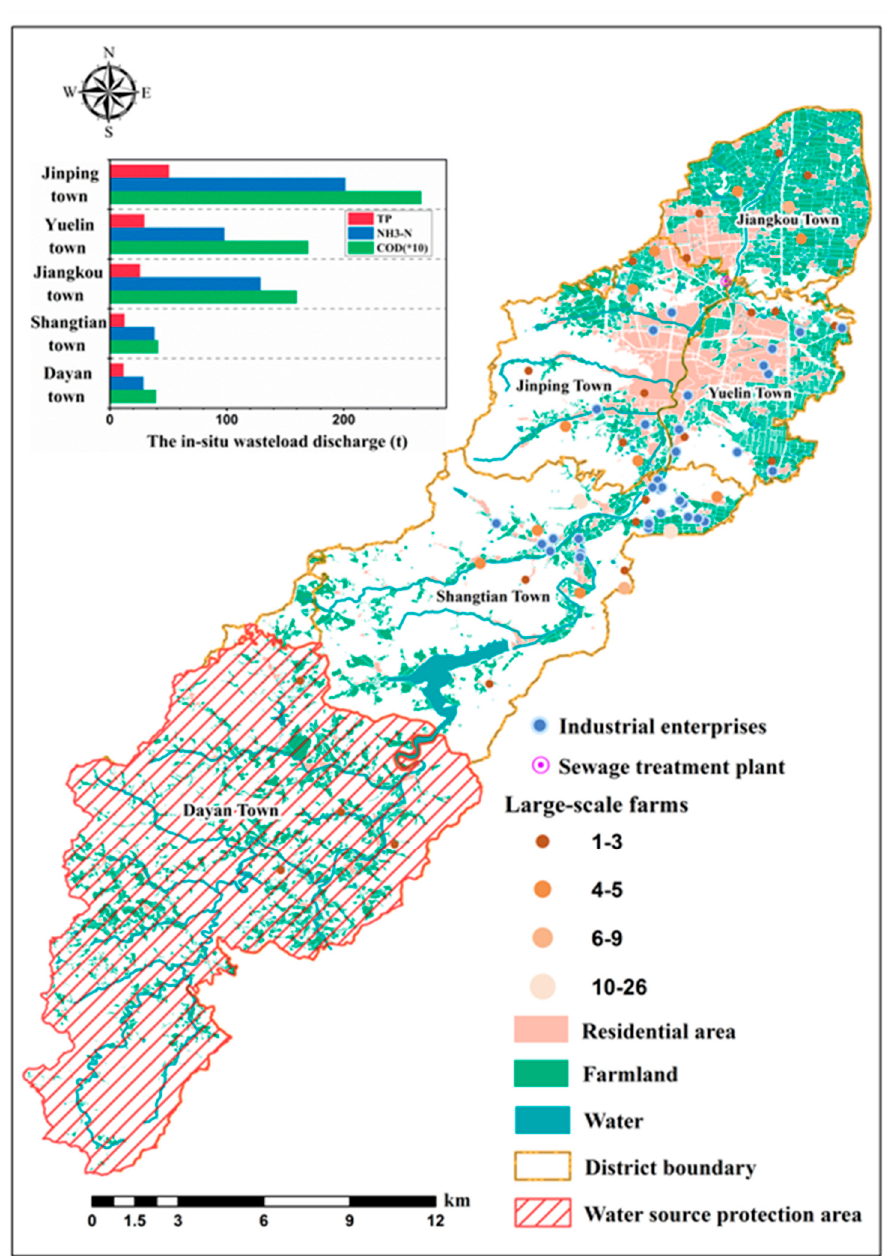
Figure 6. The administrative divisions, pollution source distribution, and geographical patterns of the Xian-jiang